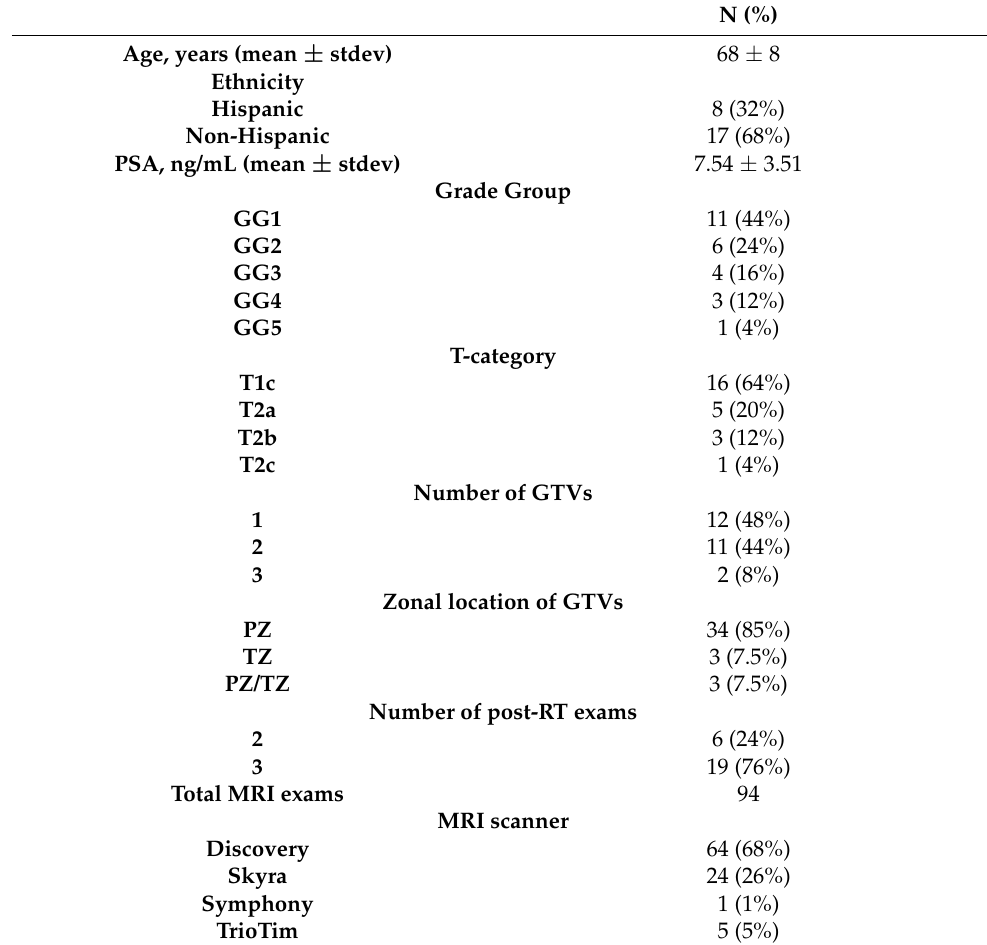
Table 2. Clinical and mpMRI exams characteristics of the patient cohort.